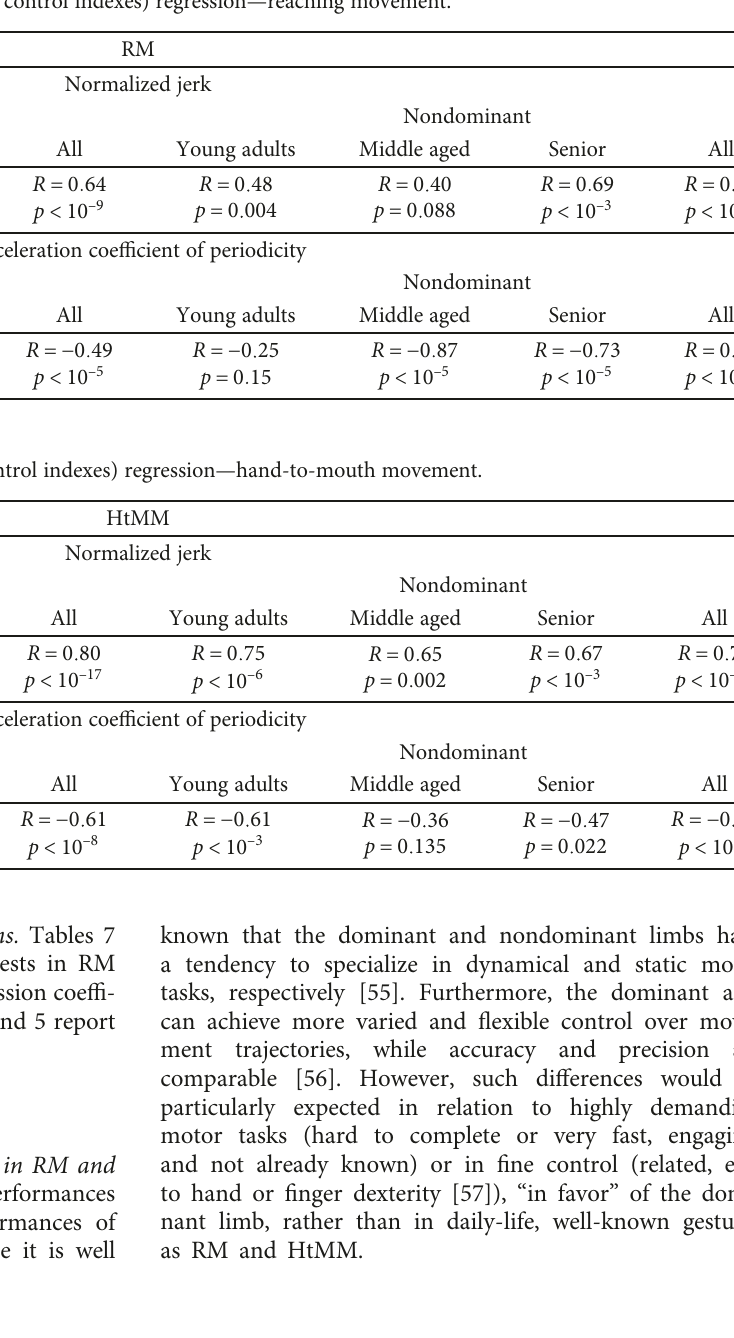
Table 7: ( T , motor control indexes) regression — reaching movement.